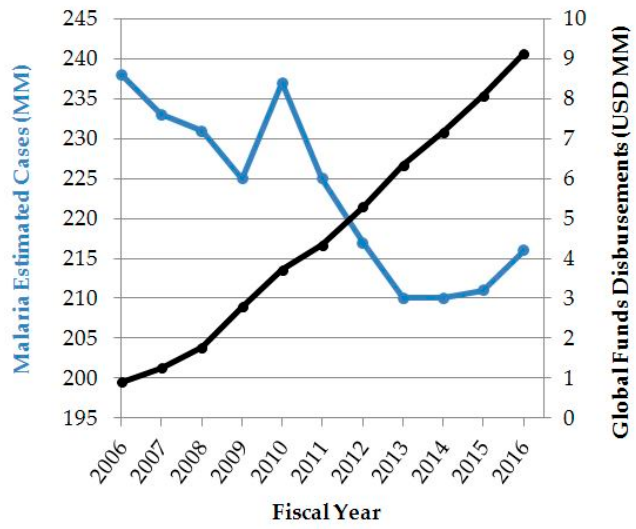
Figure 3. Relationship between global spending trends and estimated cases of malaria [10–12].